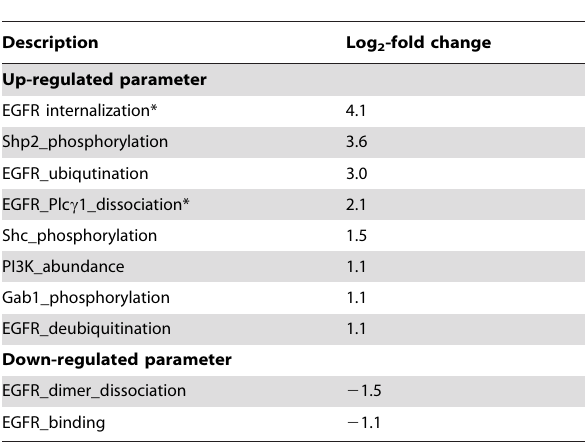
Table 1. Up or down regulated parameters with at least two- fold change of the mean value for each parameter distribution (p-value less than 0.001).